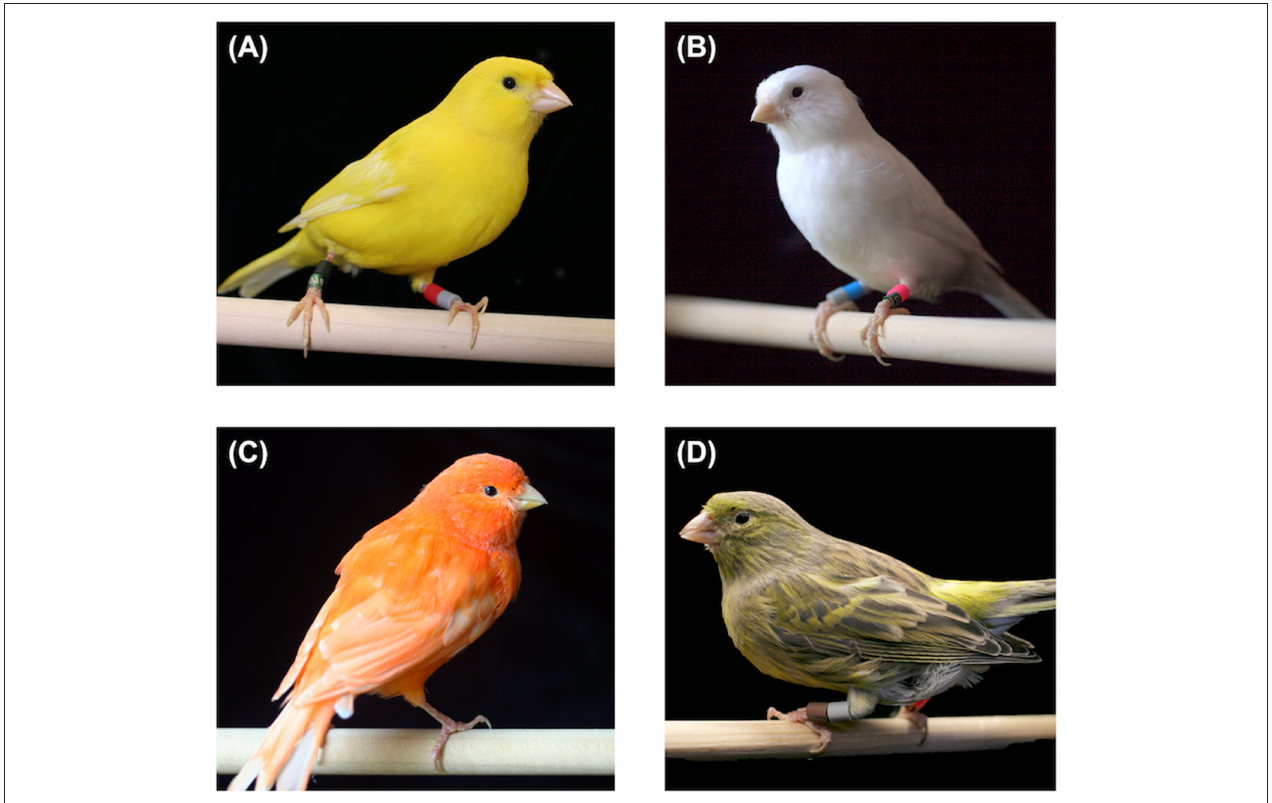
FIGURE 1 | The four color types of canaries used in these experiments: yellow (A) , white recessive (B) , and red factor (C) color-bred lipochromes, and green song-bred Spanish Timbrado (D) .